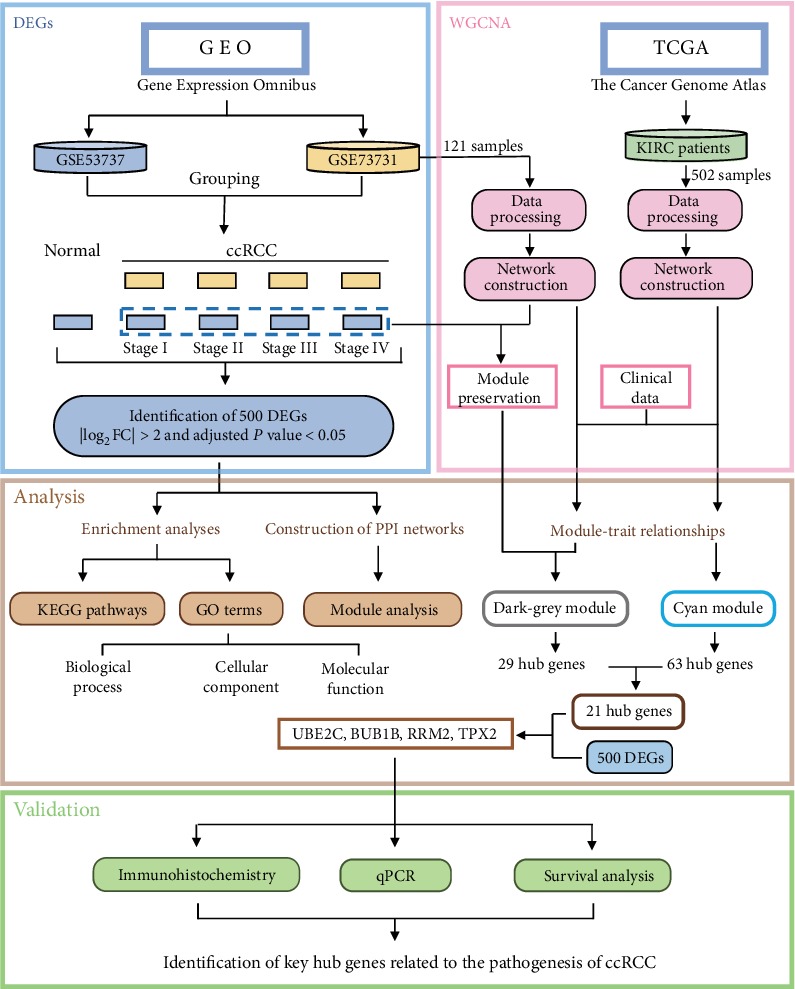
The flow chart of our study.